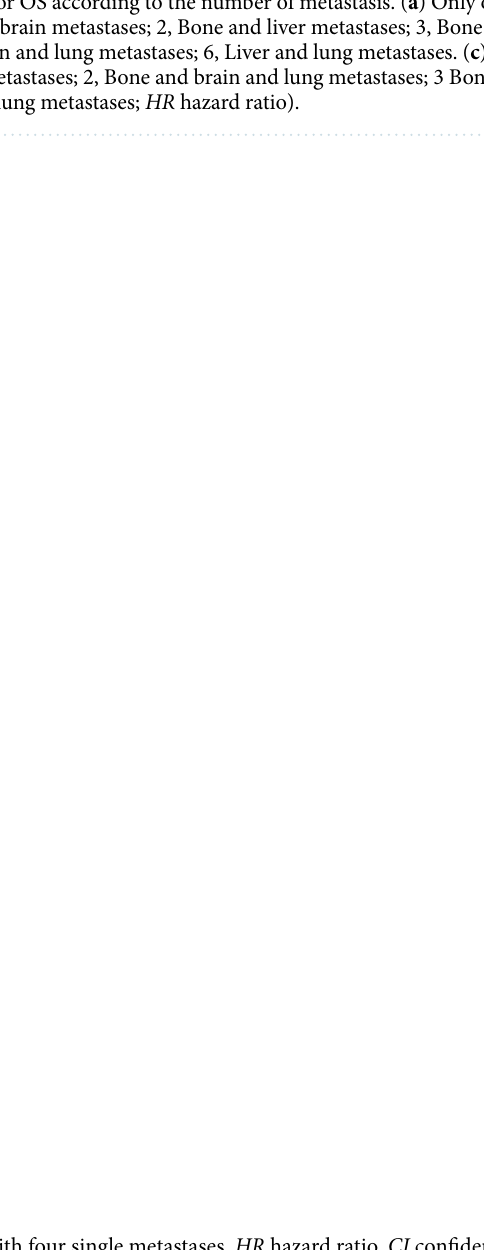
Table 4. Multivariate survival analysis of patients with four single metastases. HR hazard ratio, CI confidence interval, Ref reference; RCC renal cell carcinoma.